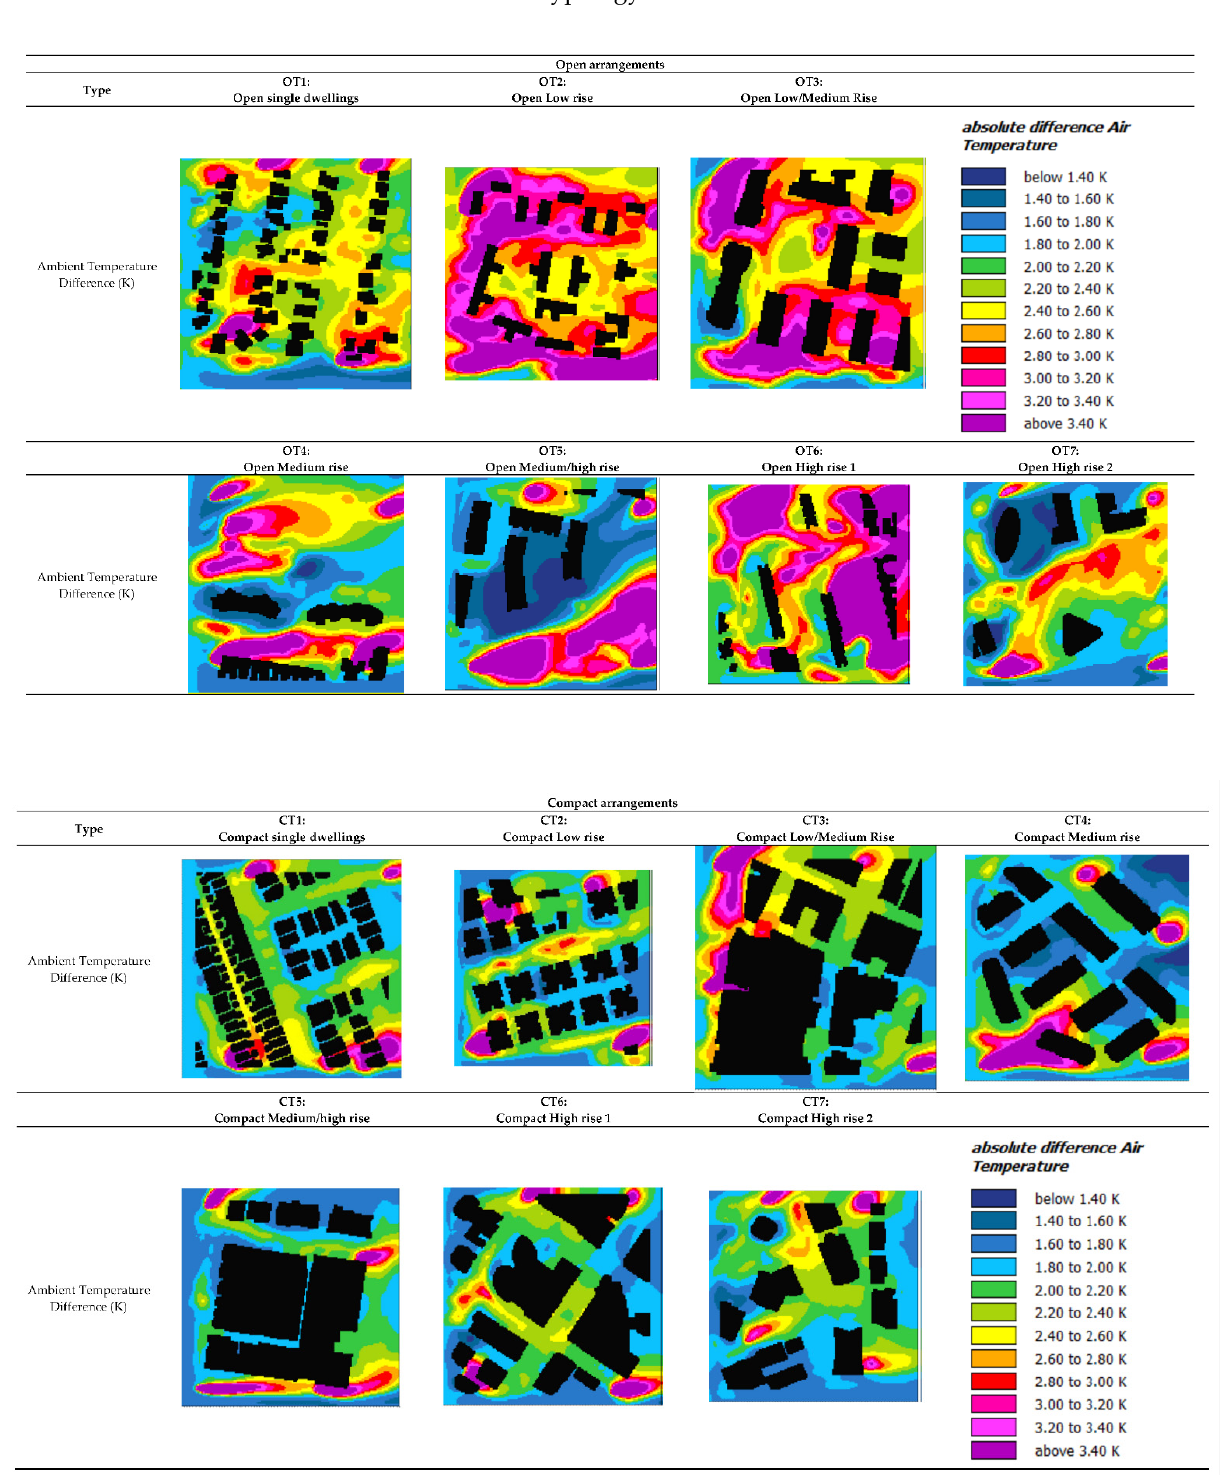
Figure 5. Ambient Temperature Comparison Charts for mitigated vs unmitigated cases and 14:00.